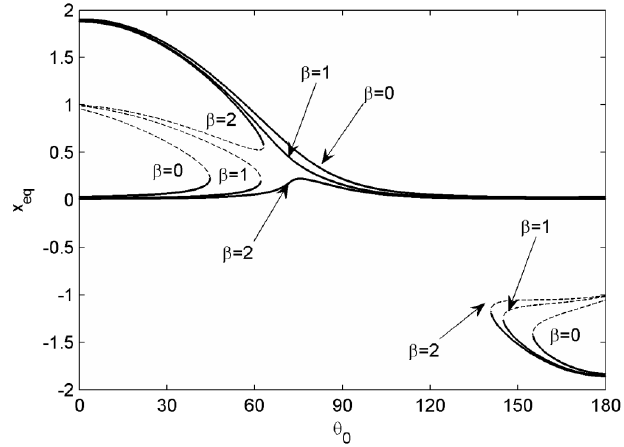
Figure 8. Steady-sliding equilibrium curve with respect to θ o at µ o = 0.5.